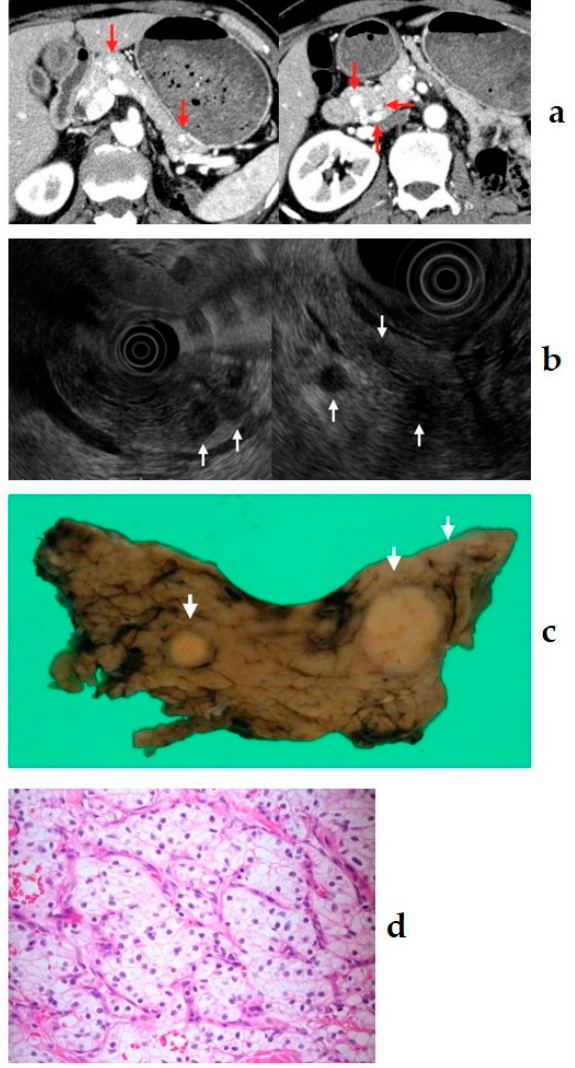
Figure 7. ( a ) Contrast-enhanced computed tomography (CT): many lesions with early hyperenhancement are seen in the head, body, and tail of the pancreas (red arrow). ( b ) Endoscopic ultrasound (EUS): many small hypoechoic masses are observed (white arrow). ( c , d ) Resected specimen: multiple tumors are observed throughout the pancreas (white arrow); they were clear cell carcinomas (400 × ). The patient had undergone left radical nephrectomy for renal cell carcinoma eight years ago.